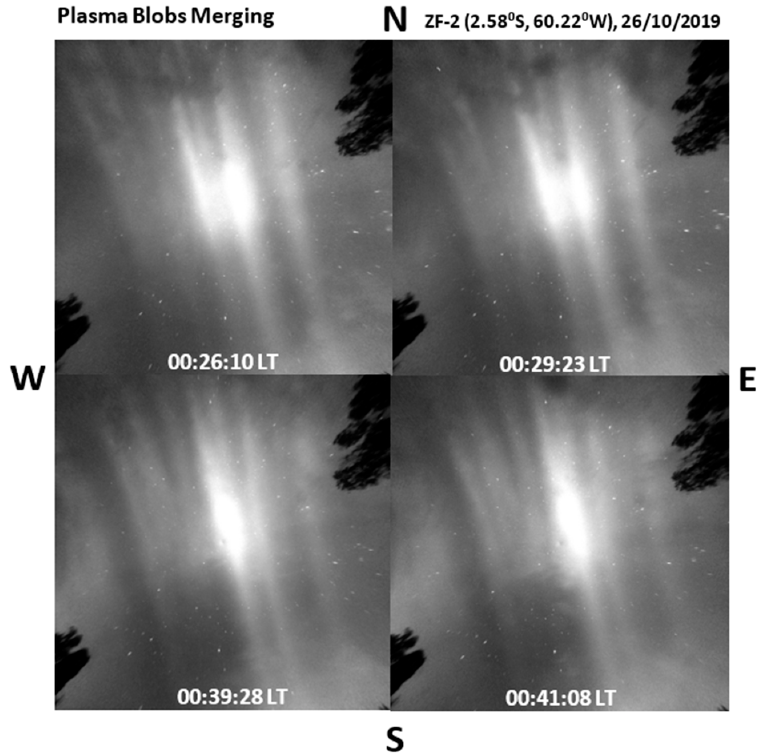
Figure 4. OI 630.0 nm emission all-sky images obtained at ZF-2 on 26 October 2019, showing plasma blobs merging. Unwarped images corresponding to a mapped area of the processed image of 1024 km × 1024 km at the OI 630 nm airglow layer, assuming an emission altitude of 250 km. The black structures at the top-right and bottom-left of the images are trees at the imager’s location.